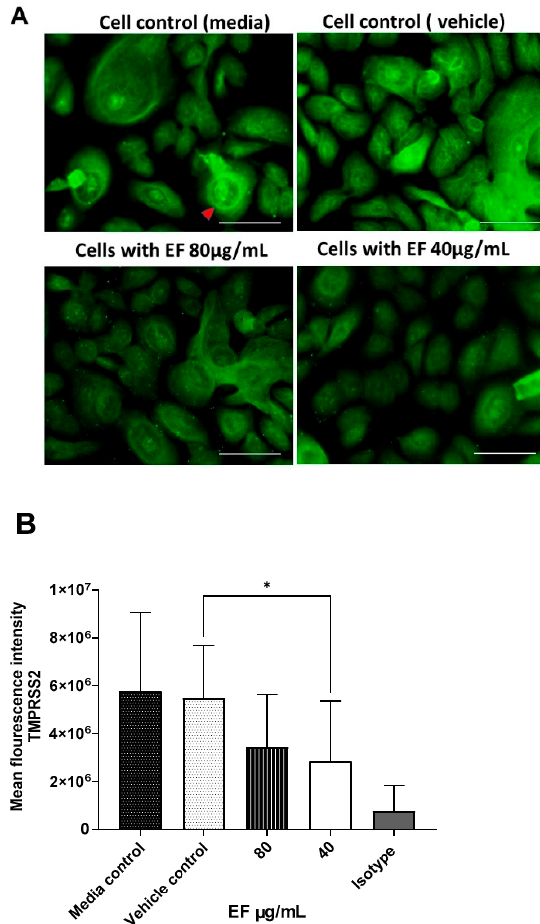
Figure 7. Inhibitory effect EF on TMPRSS-2 expression in EF pretreated HNEpC cells. Cultured HNEpC cells were treated with 80 and 40 µg/mL EF for 48 h. ( A ) Surface and intracellular immunofluorescent staining using an TMPRSS-2 antibody. ( B ) Quantification of the TMPRSS-2 signal. Graphs represent mean inflorescence values and ± SD of three independent experiments (* p < 0.05). Fluorescent intensity was calculated using Imagej software package (open source). Scale bar = 100 µm.